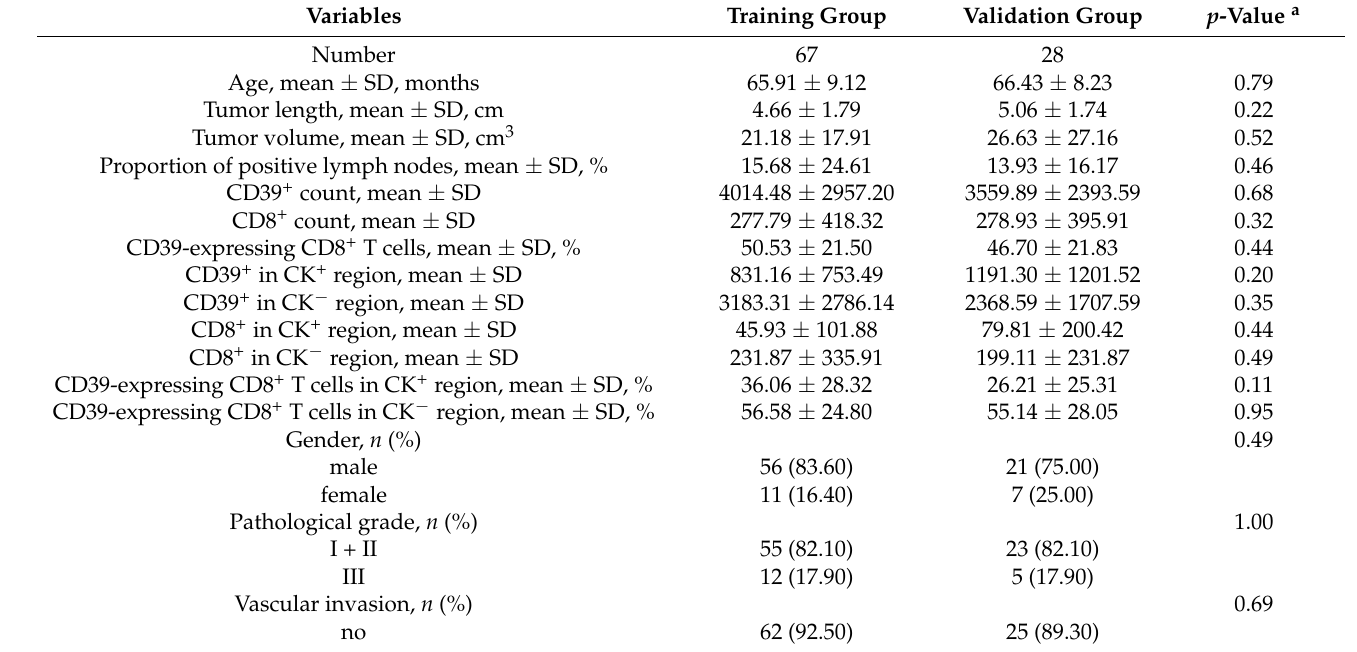
Table 1. Clinical characteristics of 95 ESCC